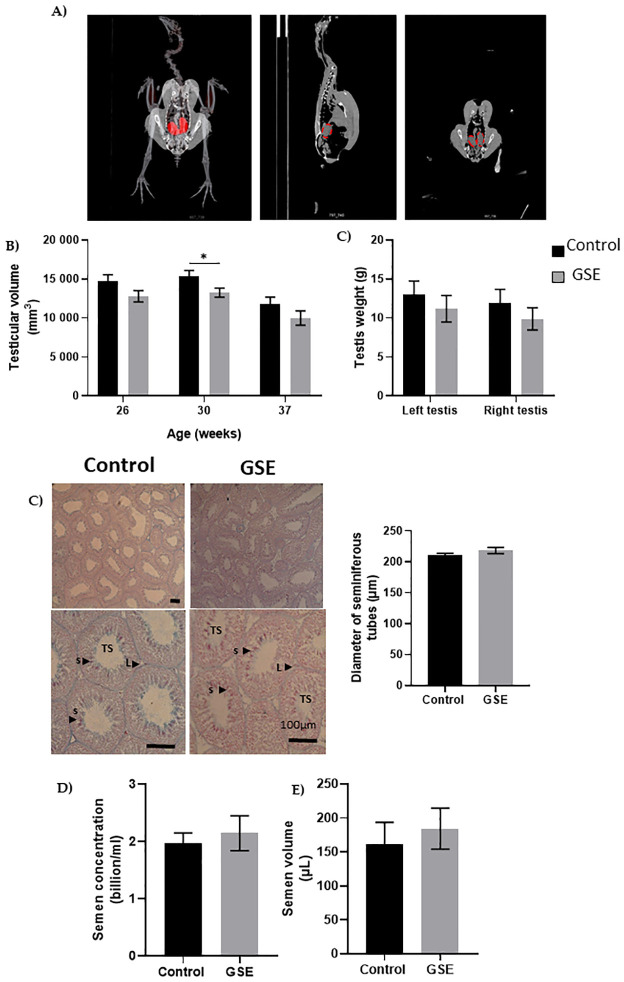
Testicular histology.(A) Representative picture of computerized tomography analysis of testes (red). (B) Volume of testes from weeks 26 to 37 (n = 10 animals) (C) Testis weight at 37 weeks of age. (C) Representative picture of seminiferous tubule histology of 37-week-old broilers. TS, seminiferous tubules composed of germ cells and Sertoli cells; L Leydig cells; s spermatozoa. The diameter of seminiferous tubules (μm) is represented to the right (n = 10 per group). (D) Semen concentration (billion/ml) (n = 10 per group) and (E) semen volume (μL) is represented in both groups (n = 10 per group). Results are presented as means ± SEM. *, p < 0.05; ***, p < 0.001.